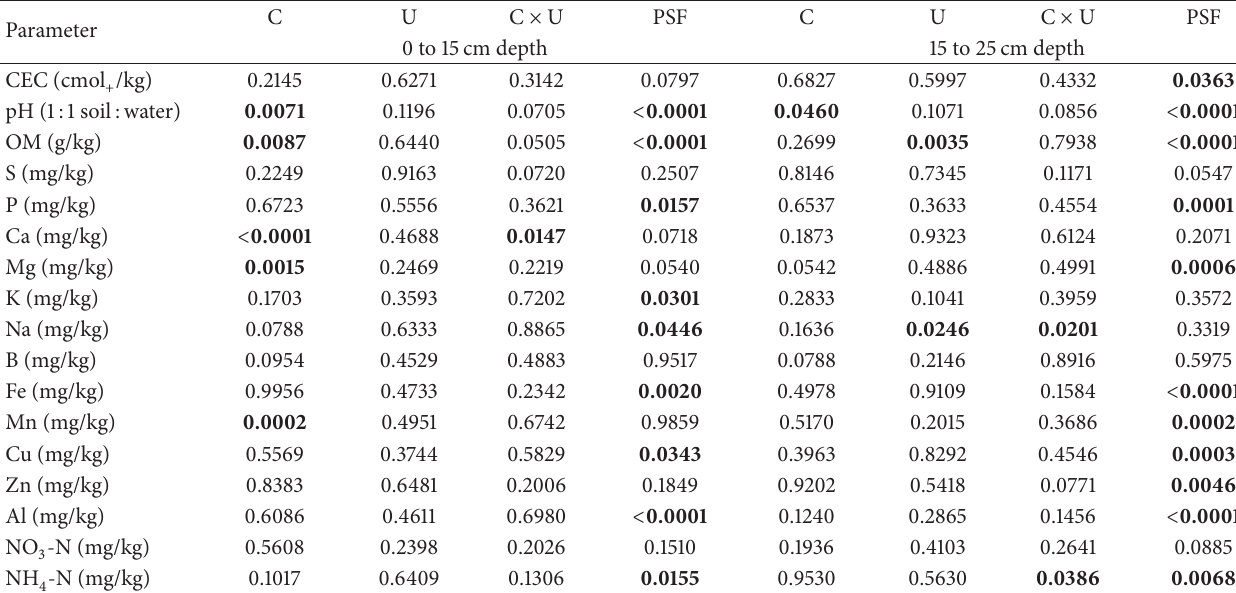
Table 10: P values for treatment effects on soil chemical properties in 0 to 15cm and 15 to 25 cm strata for models containing fixed effects of compost (C), urea (U), compost × urea (C × U), and preexperiment soil fertility measurement for each parameter sampled at 15 to 25 cm depth (PSF), with block as a random effect. Each row represents a single model for each soil depth. Significant values at P ≤ 0.05 are in